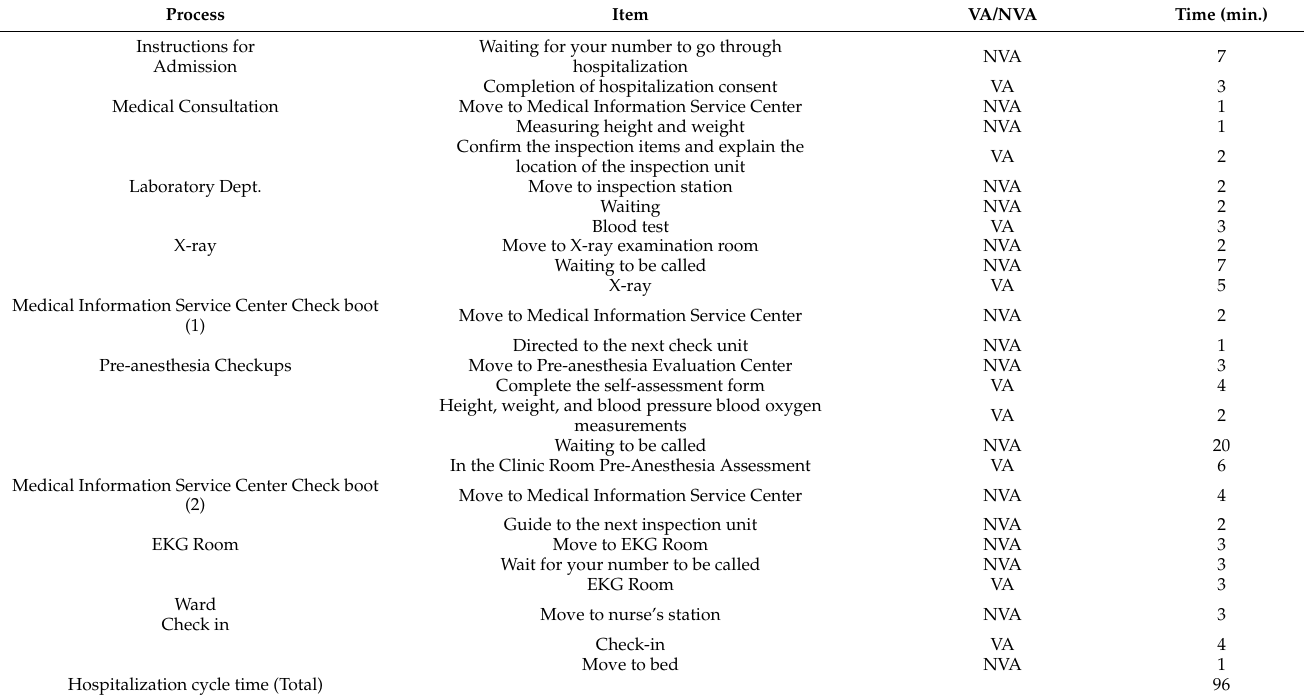
Table 3. Detailed process of the hospitalization